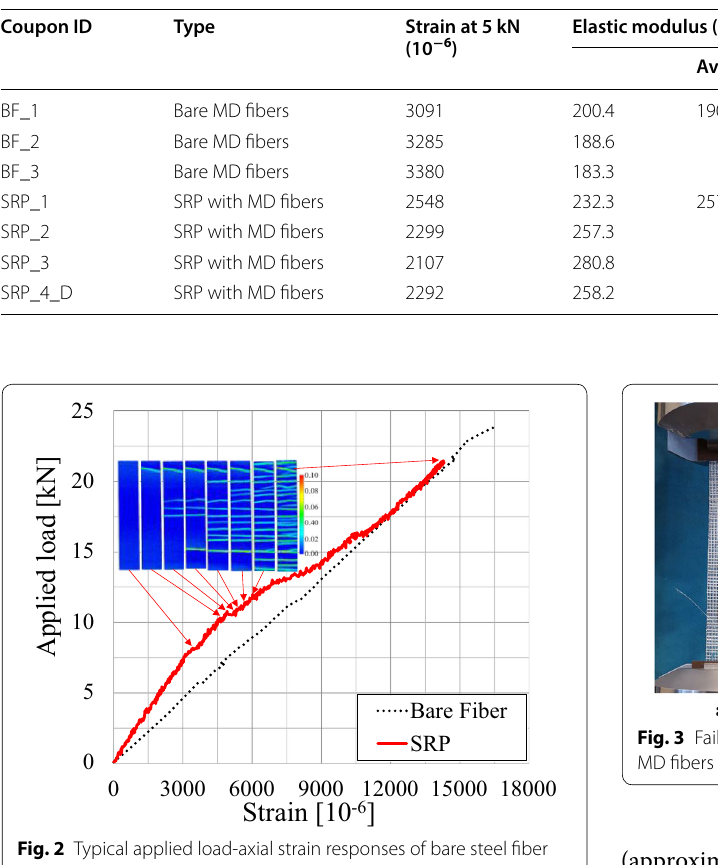
Table 2 Tensile test results of bare steel wire sheet and SRP plate with MD fibers